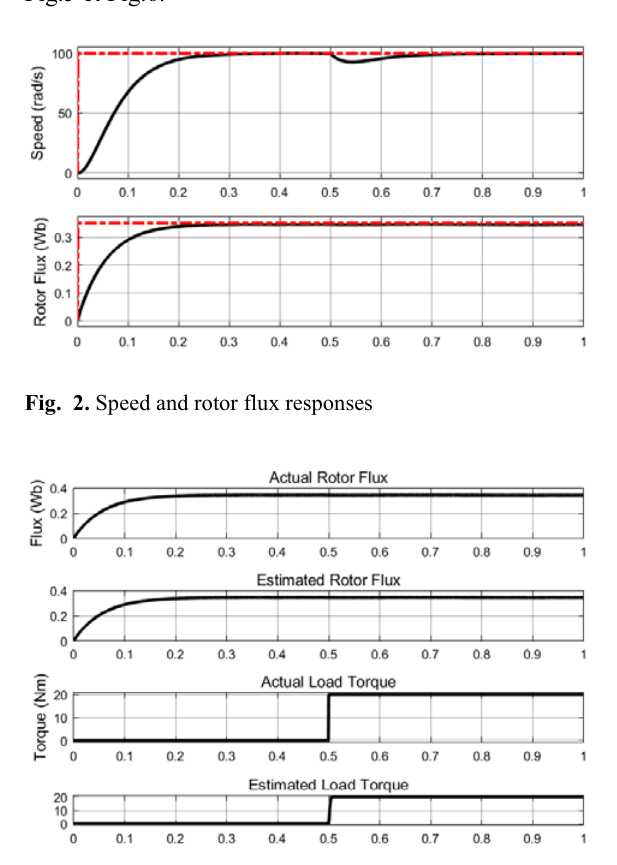
Fig. 3. Estimated rotor flux and load torque